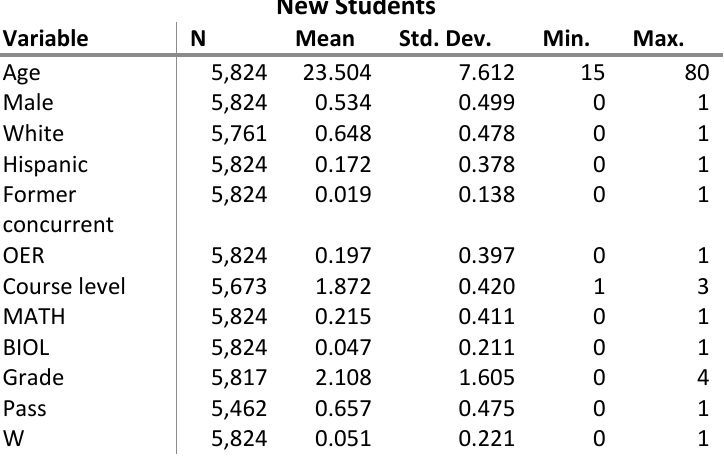
Figure 6. Table of descriptive statistics – New